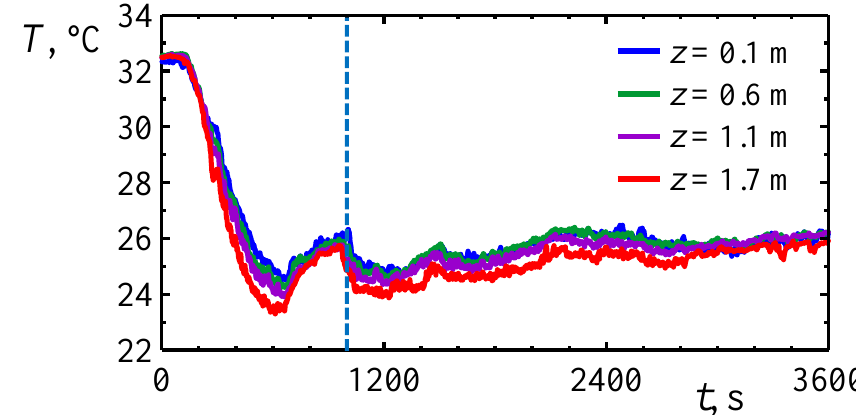
Figure 3. Air temperature time variation at the inspected points.